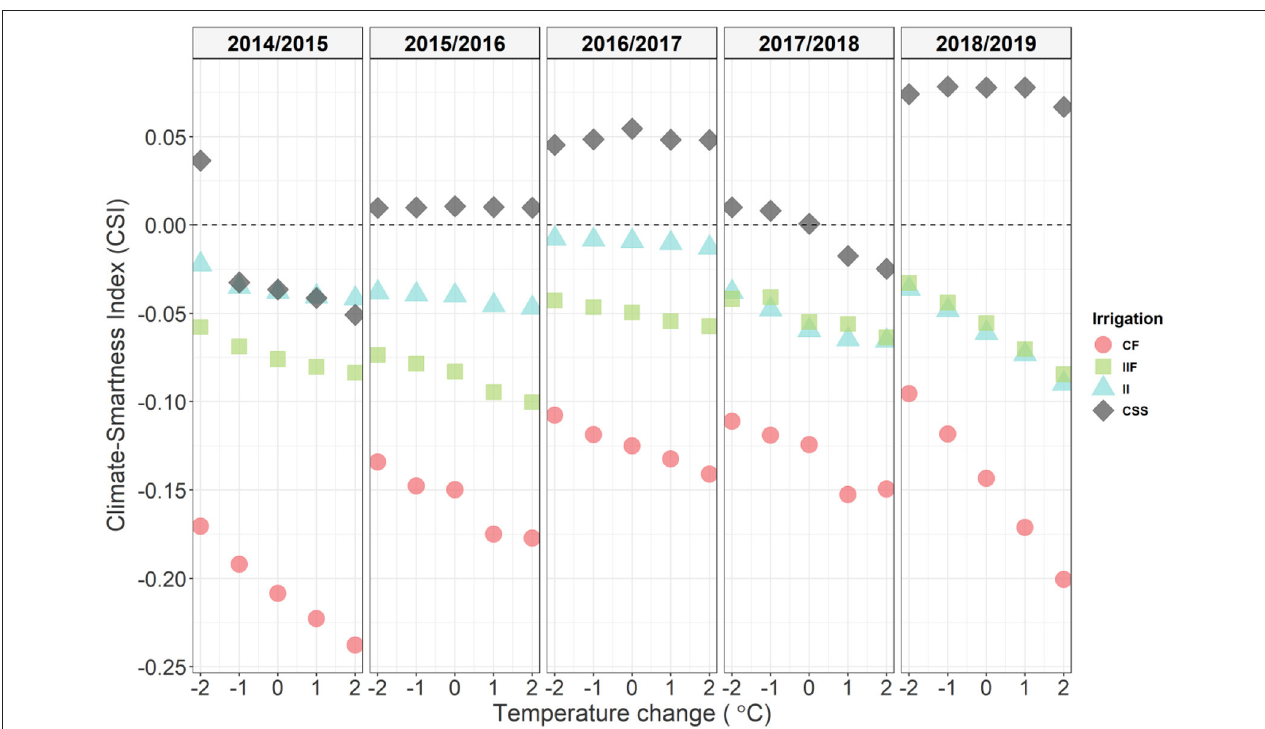
FIGURE 7 | Sensitivity analysis of Climate-Smartness Index (CSI) to changes on temperature of rice crop under Continuous flooding (CF), Intermittent Irrigation until Flowering (IIF), Intermittent Irrigation (II) and Continuous soil saturation (CSS) treatments.